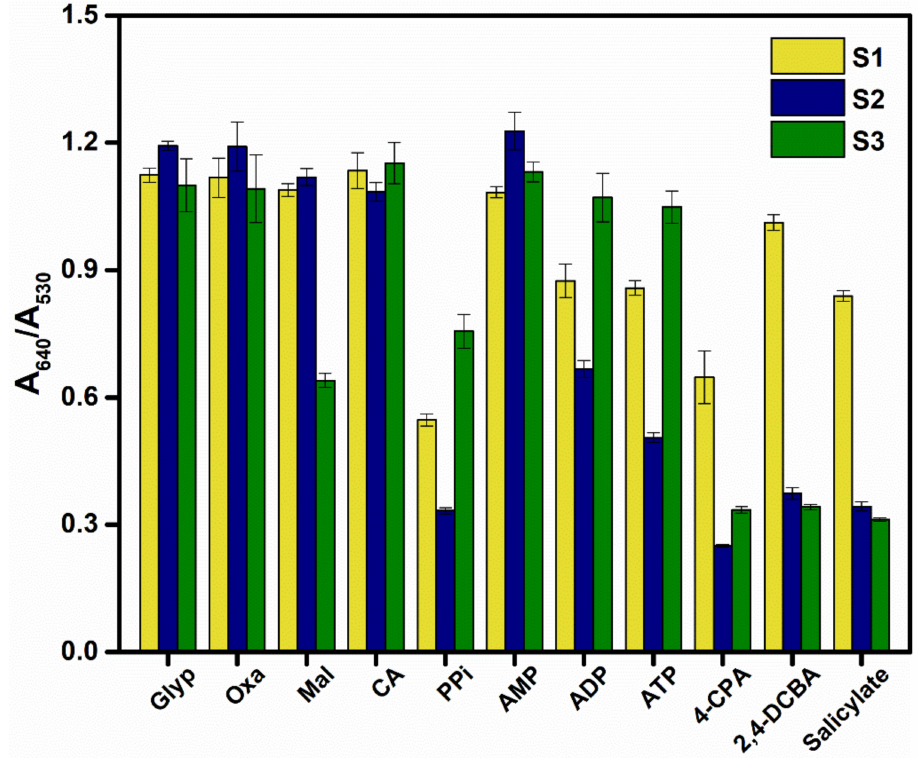
Figure 7. Colorimetric sensor response of AuNPs (S1–S3) for 11 oxyanions; error bars reflect the standard deviations of 20 replicates of each sensor–oxyanion